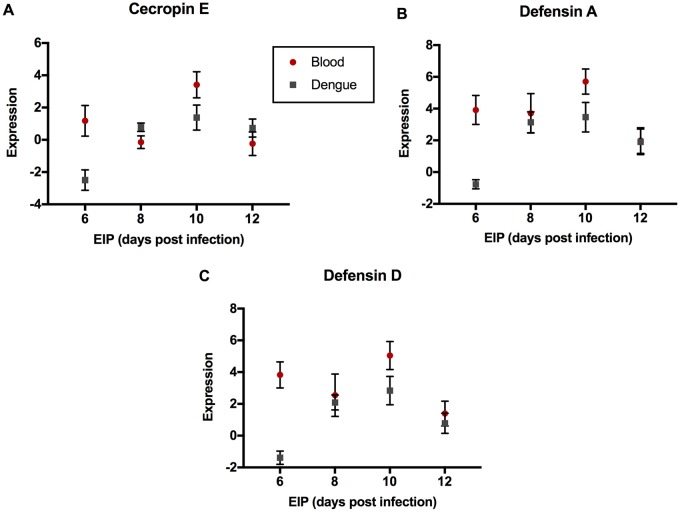
—Genes of enriched GO term GO:0006952 defense response. Expression levels by EIP phenotype of (A) Cecropin E, (B) Defensin A, and (C) Defensin D are shown. Expression levels were estimated from read counts from RNAseq data. Red circles depict mosquitoes fed with a naïve blood meal, while gray squares depict those fed with a viremic blood meal. Mean and SEM are shown in graphs (n = 6 per group per treatment).